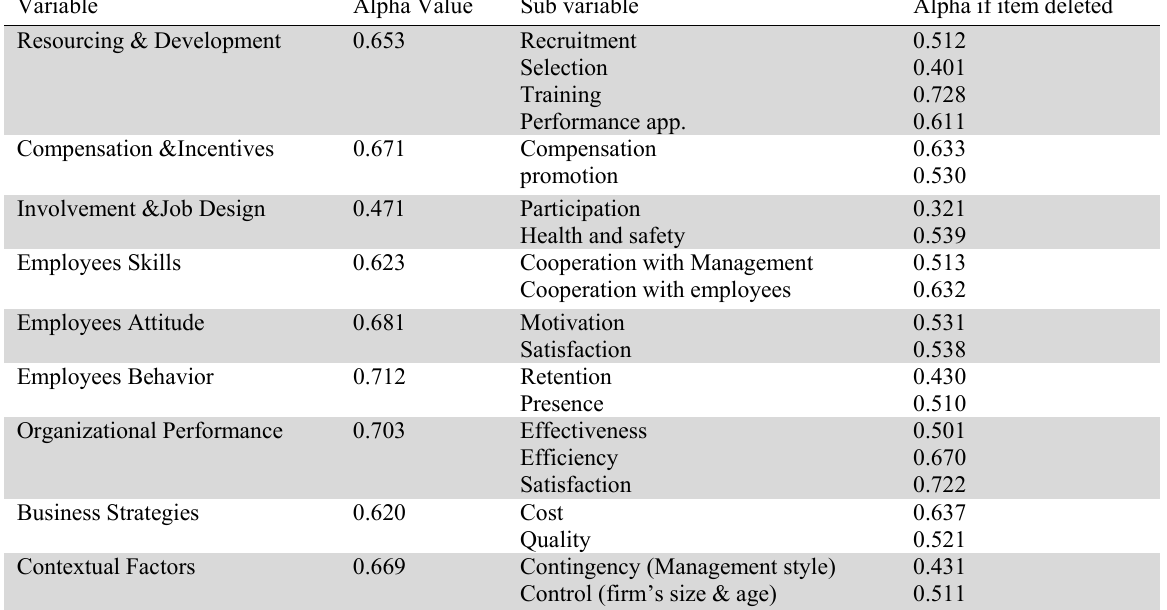
Reliability Analysis of